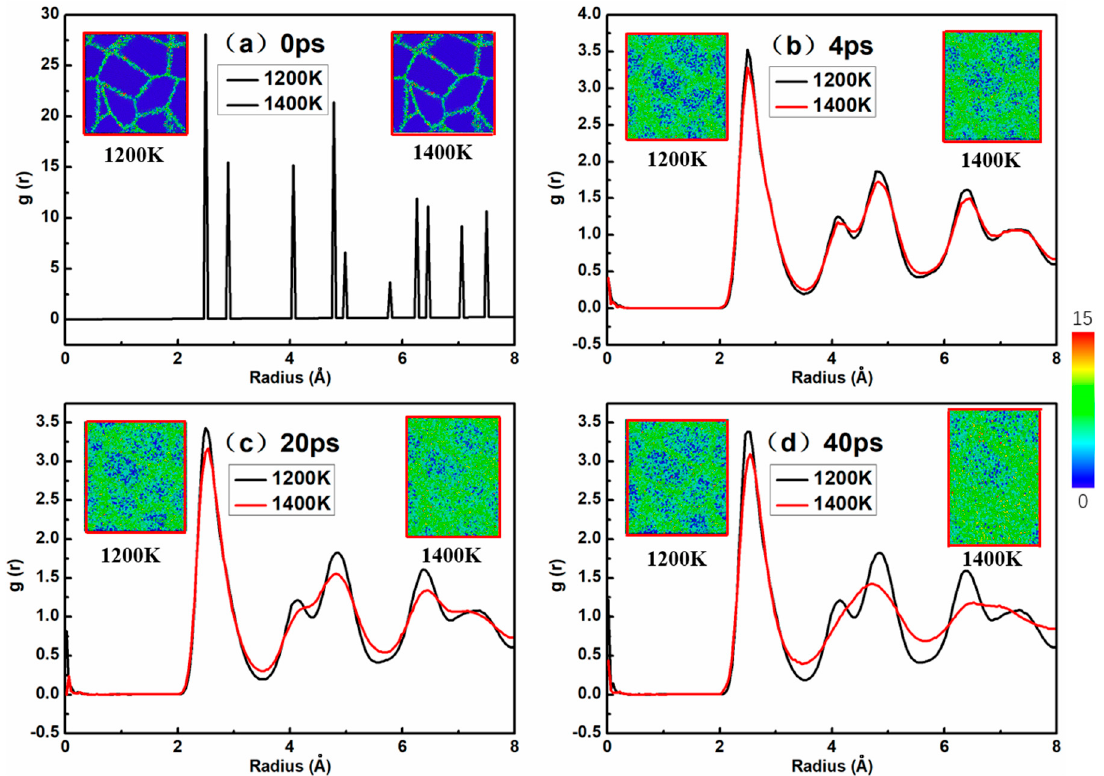
Figure 3. Radial distribution function plots with atomic snapshots of a representative nanocrystalline NiAl model with 4.5 nm coarser grain, colored as per CSP during creep deformation for ( a ) 0, ( b ) 4, ( c ) 20, ( d ) 40 ps under the stress levels of 2.0 GPa at 1200 and 1400 K.